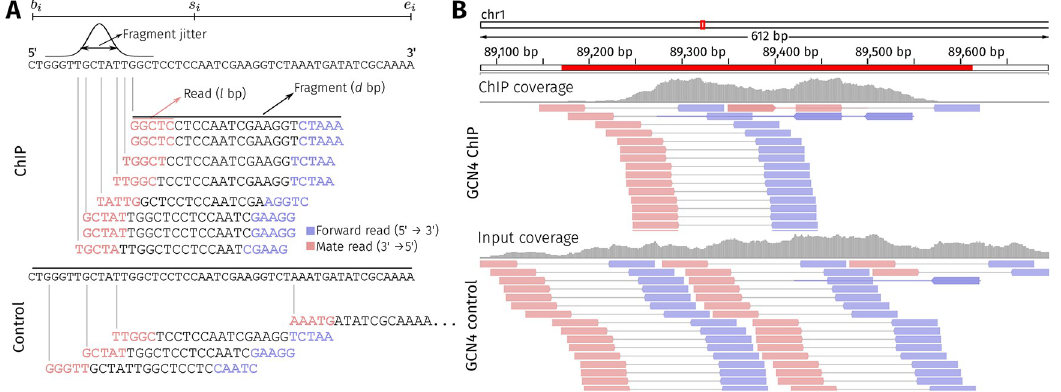
Fig 6. Example of simulating sequence reads using ChIPulate. (A) Illustration of ChIPulate’s read generation method. The i-th genomic location is a genomic interval ( b , e ), with the “summit” of the interval located at s . The total read count ( r ) and unique i i i i read count ( u i ) at the i-th interval in the ChIP and control samples are calculated as described in Fig 1. The starting positions of fragments in the ChIP sample are drawn from a Gaussian distribution with mean s /2 and standard deviation j , where d is the i − d fragment length and j is the fragment jitter. In the control sample, fragment start positions are drawn from a Uniform( b i , e i ) distribution. The Phred-33 quality value of every base is set to be 75, which corresponds to a base-calling error probability of 10 − 42 . The read length is set to l bp, and both paired and single end reads can be simulated. (B) Paired-end reads simulated from genomic intervals containing an experimentally determined GCN4 binding site. The genomic intervals containing GCN4 binding sites were taken from an earlier publication [34]. Paired-end reads of 50 bp in length were simulated using ChIPulate, with the fragment jitter set at 50 bp and the fragment length set at 200 bp. The binding energy of the highest affinity GCN4 binding site in each interval was computed using the GCN4 binding energy matrix from the BEEML database. The remaining ChIPulate parameters were set at their default values.